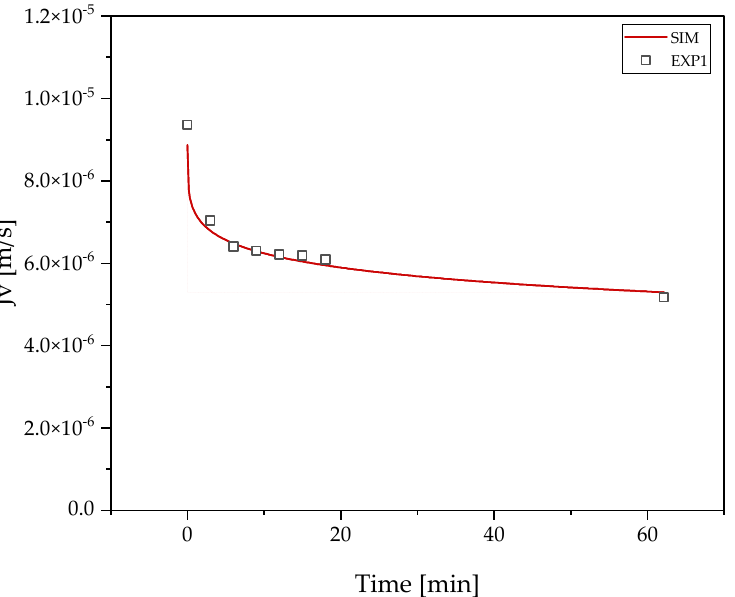
Figure 6. Demonstration of early digital twin-assisted prediction of the filtration progress as well as endpoint determination.